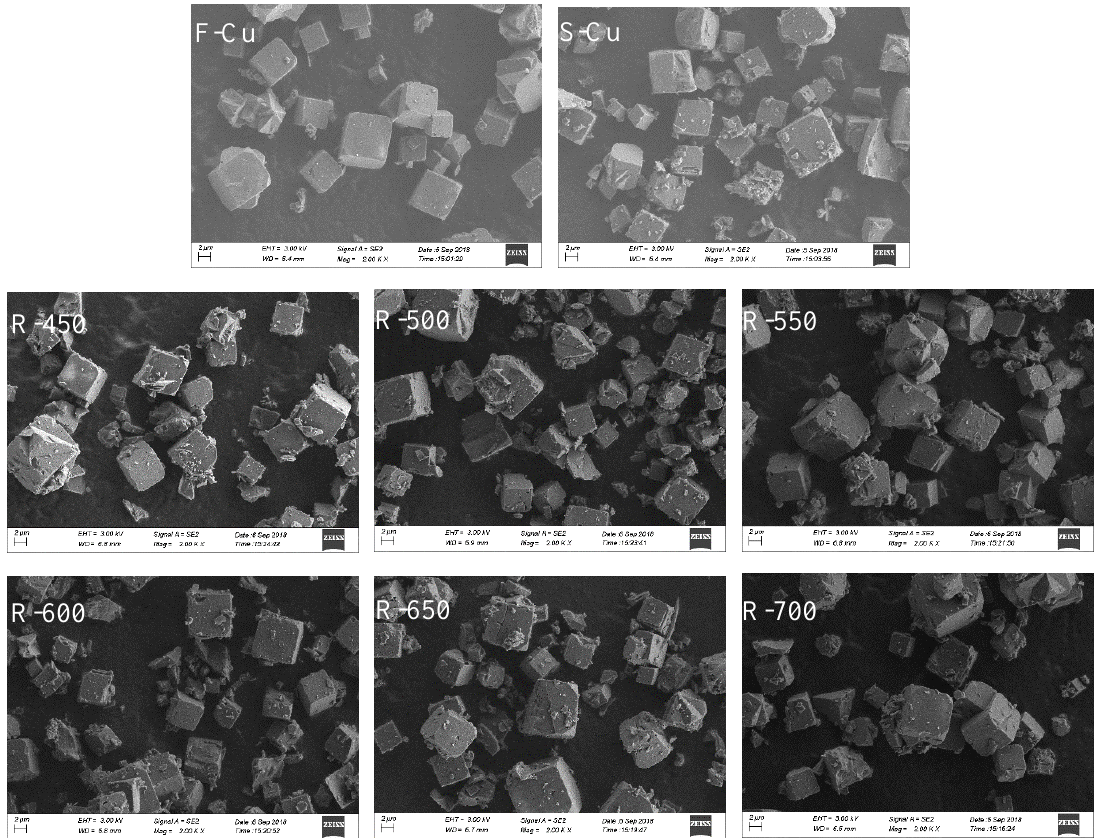
Figure 3. SEM images of Cu-SSZ-13 catalysts in fresh, sulfated and regenerated state .